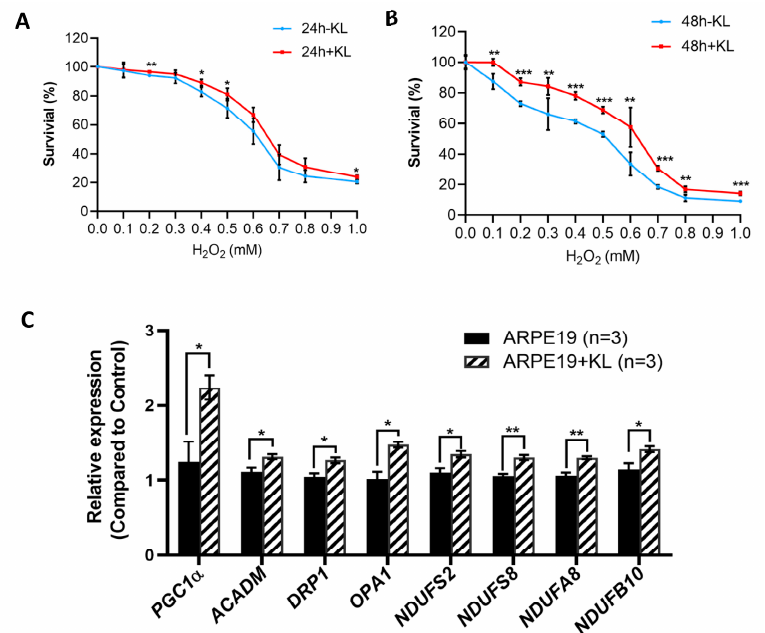
Figure 1. KL protein protects RPE from oxidative stress and upregulates the expression of genes related to mitochondrial activity. Cell viability assays of ARPE19 treated with increasing concentrations of H 2 O 2 for 24 h ( A ) or 48 h ( B ) with or without 10 nM recombinant KL protein. Addition of KL for 48 h significantly increased the cell viability of ARPE19 at all H 2 O 2 concentrations compared to control (without KL). The mean ± SD and the p -values were calculated for statistical significance. Holm–Sidak t -test was performed using GraphPad Prism 8.3.0. * p ≤ 0.05, ** p ≤ 0.01, *** p ≤ 0.001. ( C ) qPCR analyses of ARPE19 incubated with recombinant KL for 48 h revealed an increase in the expression of PGC1 α (related to mitochondrial biogenesis, regulation of antioxidant genes and energy metabolism), ACADM (downstream target of PGC-1 α , required by the initial step of fatty acid beta-oxidation), DRP1 and OPA1 (associated with mitochondrial fission and fusion), and respiratory chain complex I subunits ( NDUFS2, NDUFS8, NDUFA8, NDUFB10 ), as compared to control. Graph represents mean ± SEM of three independent experiments. Holm–Sidak t -test was performed using GraphPad Prism 8.3.0. * p ≤ 0.05 , * * p ≤ 0.01.